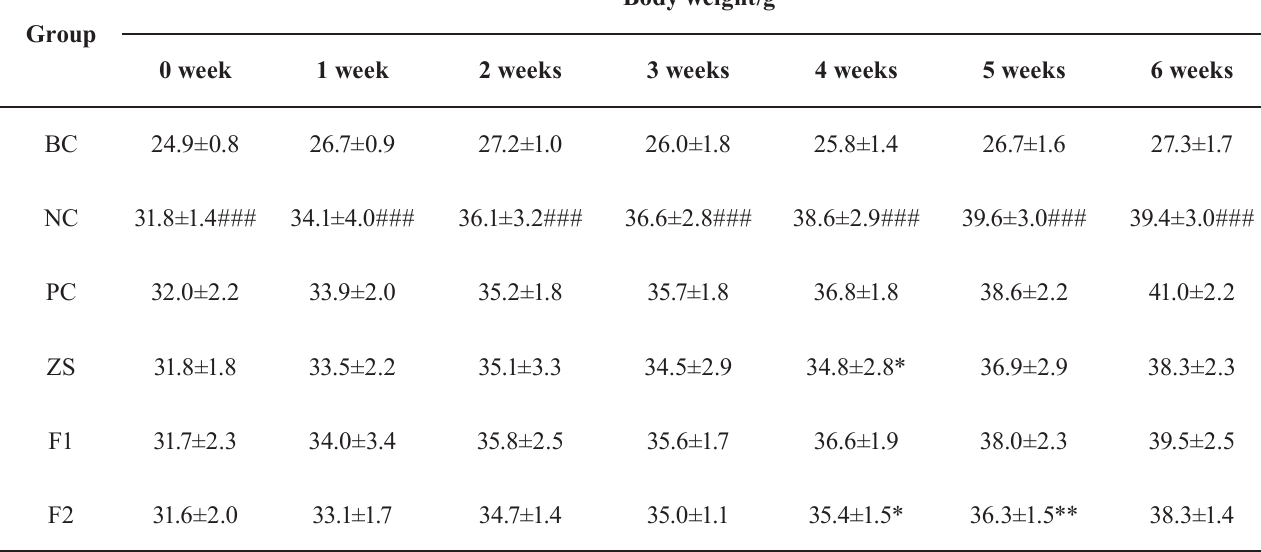
TABLE I - Effect of BCLE on body weight in KK-A y mice (n = 12) ( ` x ± s )